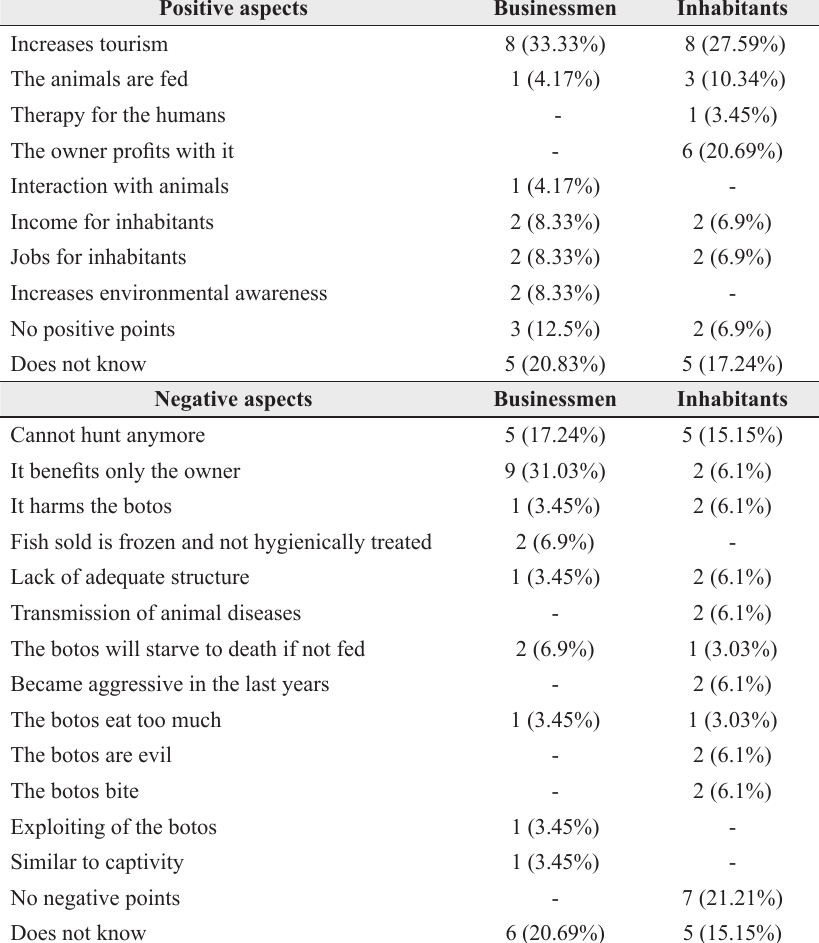
Positive and negative aspects of the activity of provisioning botos, as perceived by businessmen and inhabitants from Novo